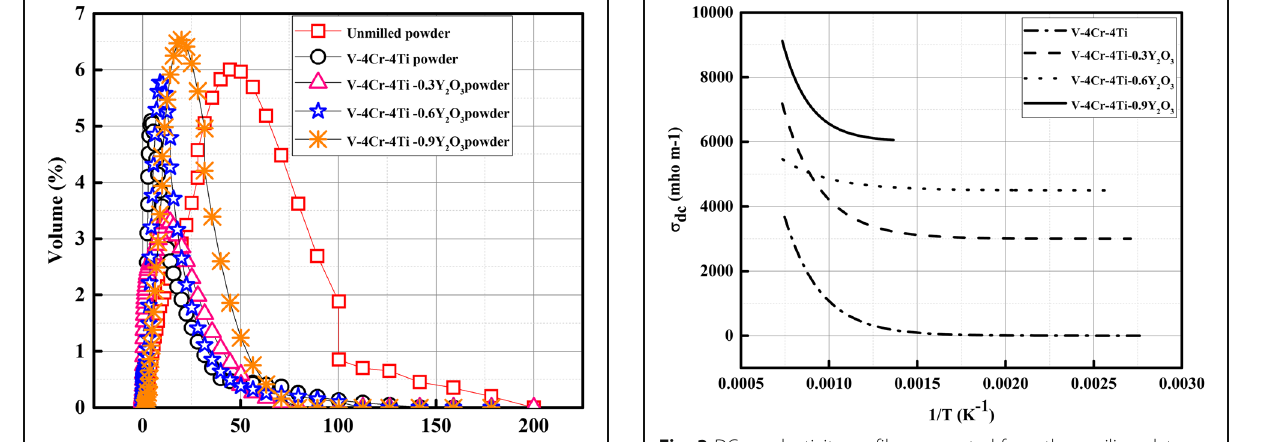
Fig. 3 DC conductivity profiles computed from the auxiliary data generated from the FAST setup while sintering V – 4Cr – 4Ti and